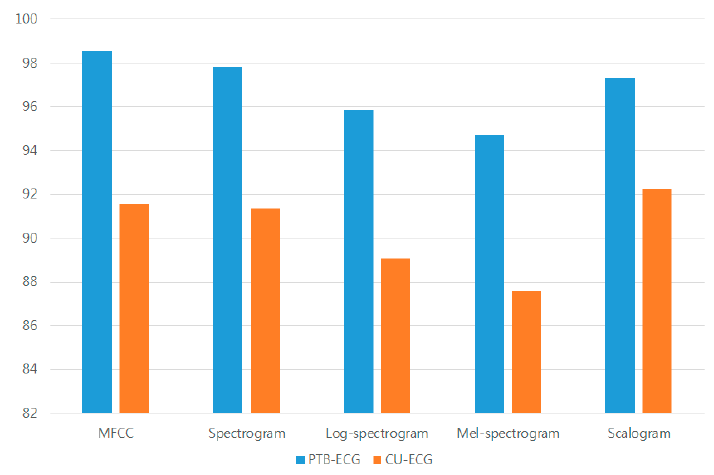
Figure 15. Comparison between the mean accuracies of the different time-frequency representations.